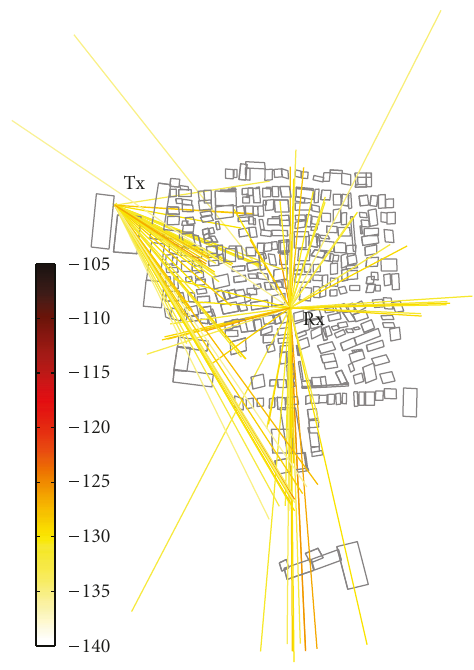
Figure 7: DoA, DoD, and TDoA (as length) for all paths at